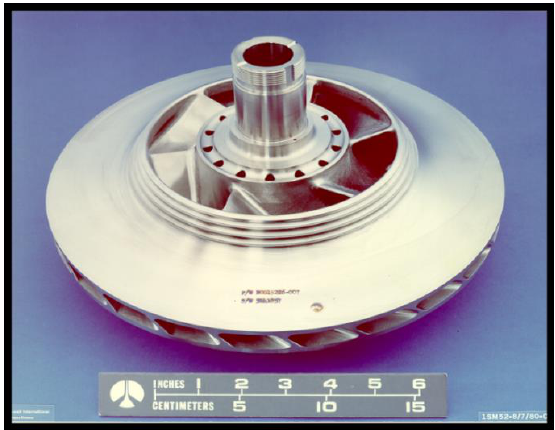
Figure 5. A Ti-5Al-2.5Sn fuel pump impeller used in the space shuttle main engine. John Halchak, Rocketdyne [10].